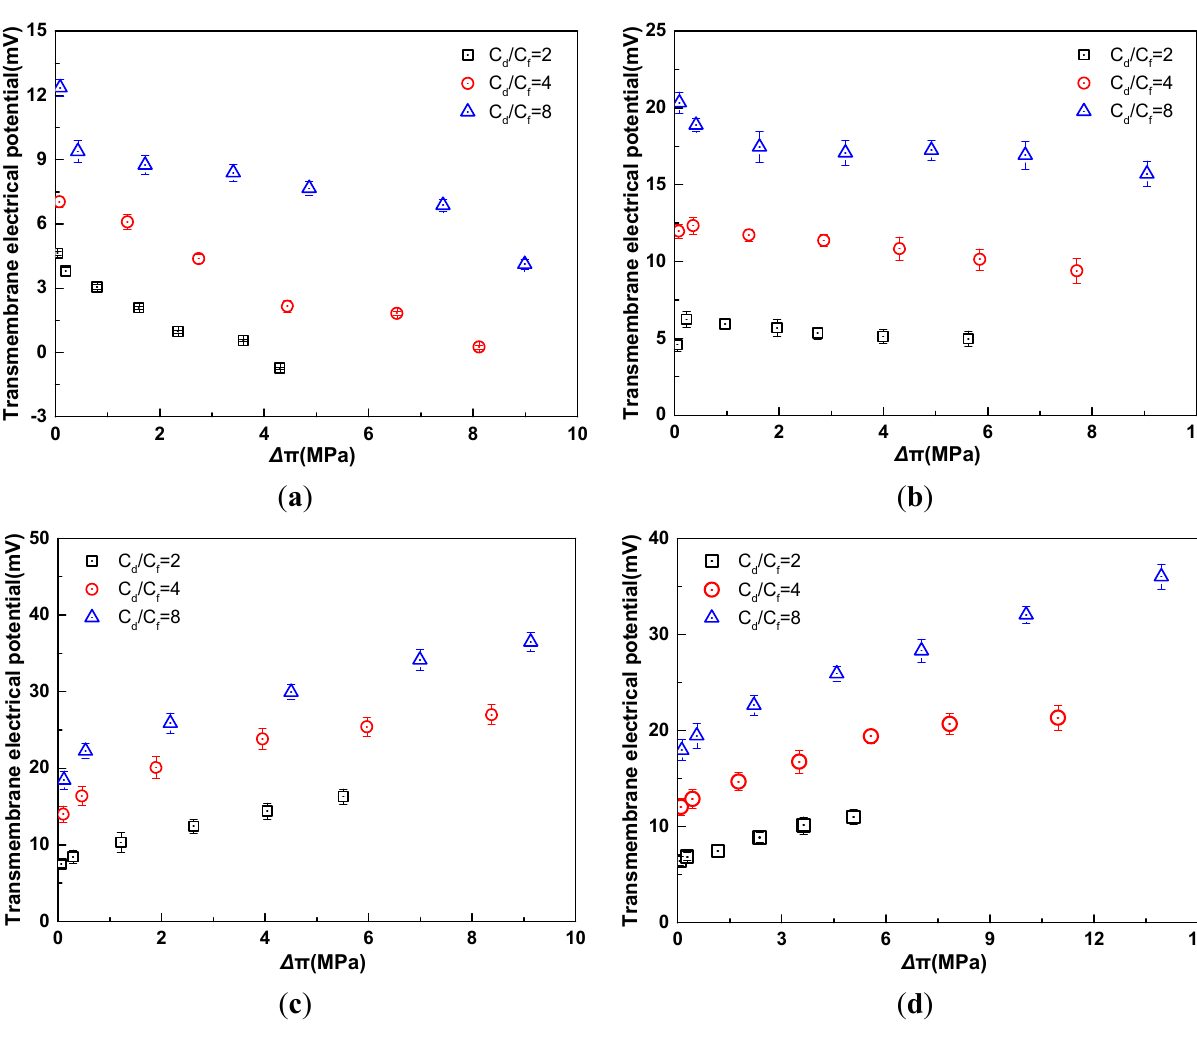
; ( d ) CaCl . The osmotic pressure difference 2 2